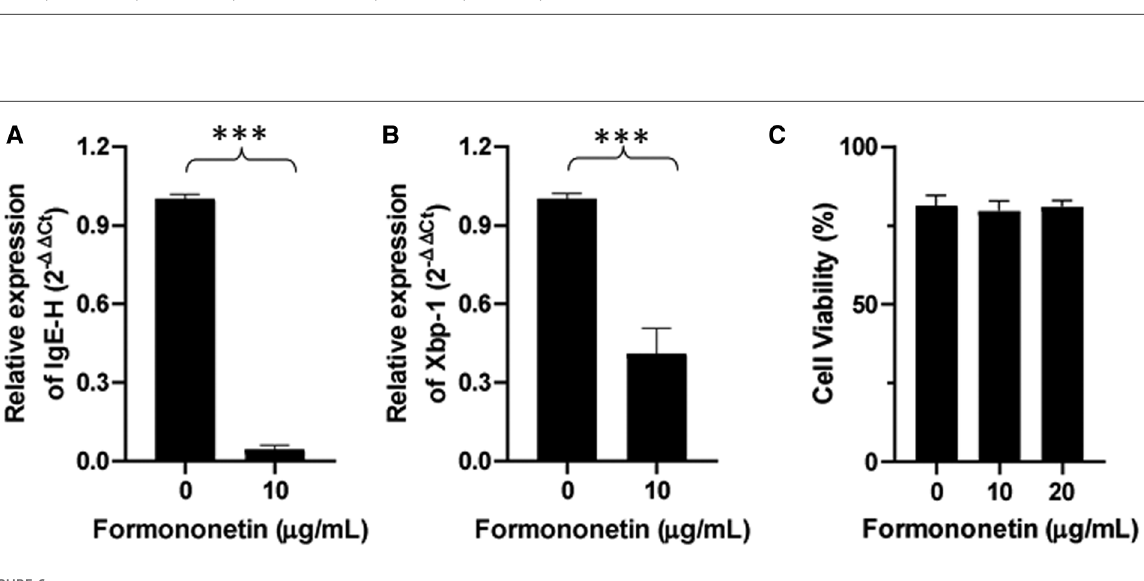
FIGURE 6 Formononetin inhibits the XBP-1 and IgE heavy chain mRNA expression in U266 cells. The relative expression level of IgE heavy chain ( A ) and XBP-1 ( B ) were determined by comparing with GAPDH mRNA expression. Fold change were calculated by the 2( − ΔΔ Ct) method. ( C ) Cell viability of formononetin on U266 cells at 10 and 20 µg/ml. Data are shown as the mean±SEM. *** p <0.001. Data represents triplicate